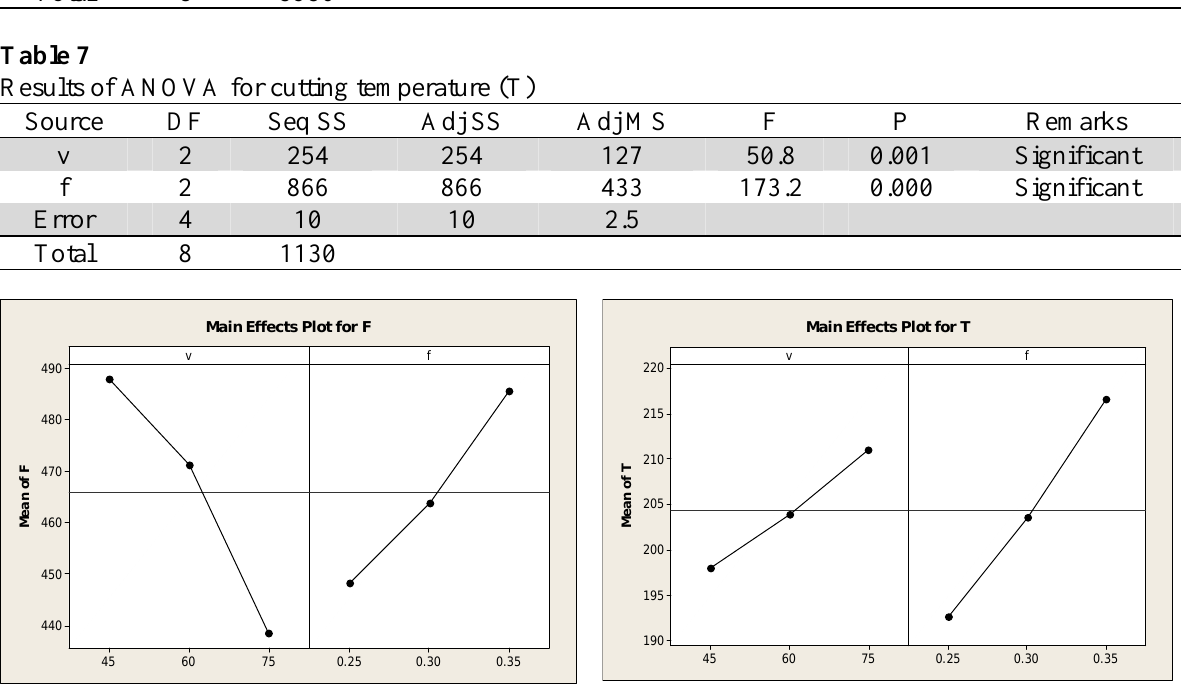
Fig. 11. Main effects plot for cutting force Fig. 12. Main effects plot for cutting